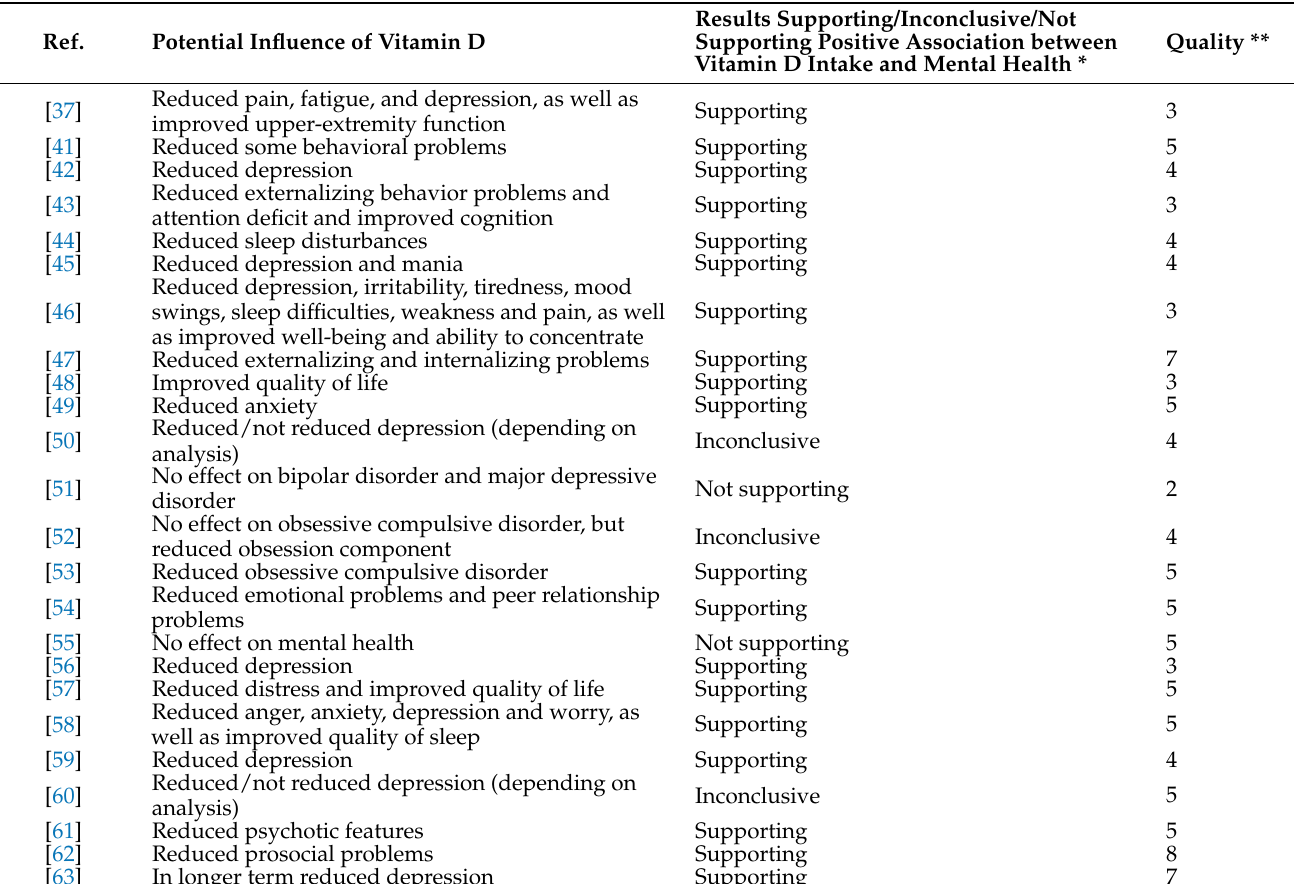
* Supporting—vitamin D associated with lower risk of mental health problems; not supporting—vitamin D not associated with lower risk of mental health problems; inconclusive—no clear association between vitamin D and risk of mental health problems; ** total score for the